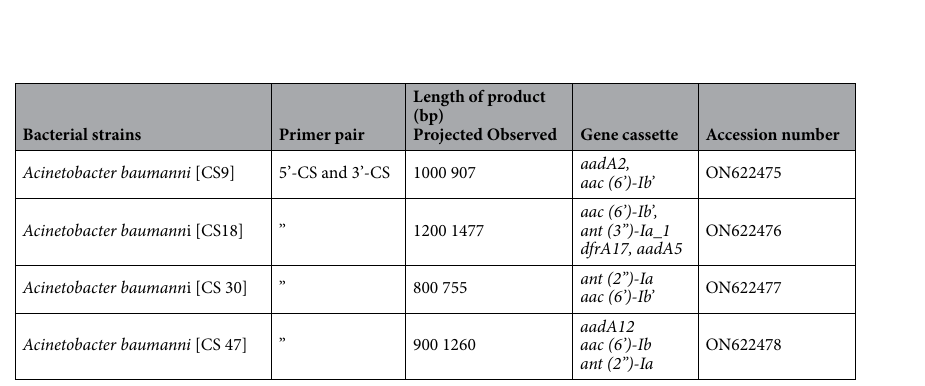
Table 4. Length product and gene cassette results of A. baumannii